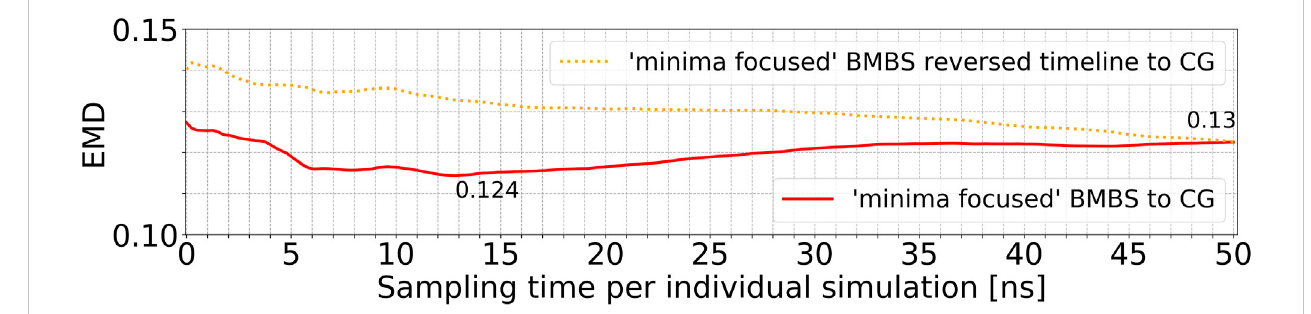
FIGURE 4 Time resolved EMDs of both forward (red solid line, same as in Figure 3D) and reversed (orange dotted line) timelines of minima-focused BMBS histograms to the CG map.